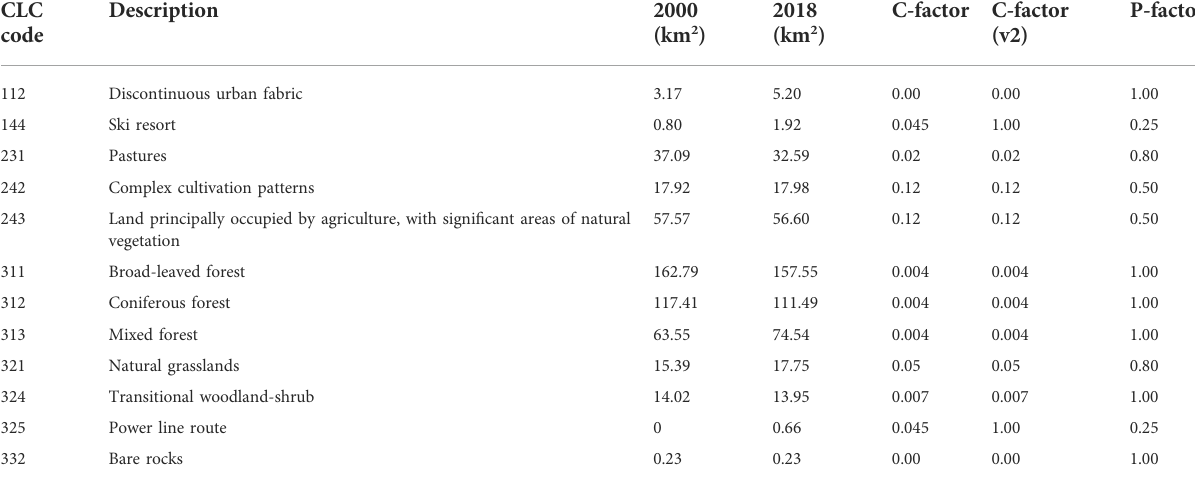
TABLE 2 CORINE land-use code and corresponding land-use factor (C) and conservation practice factor